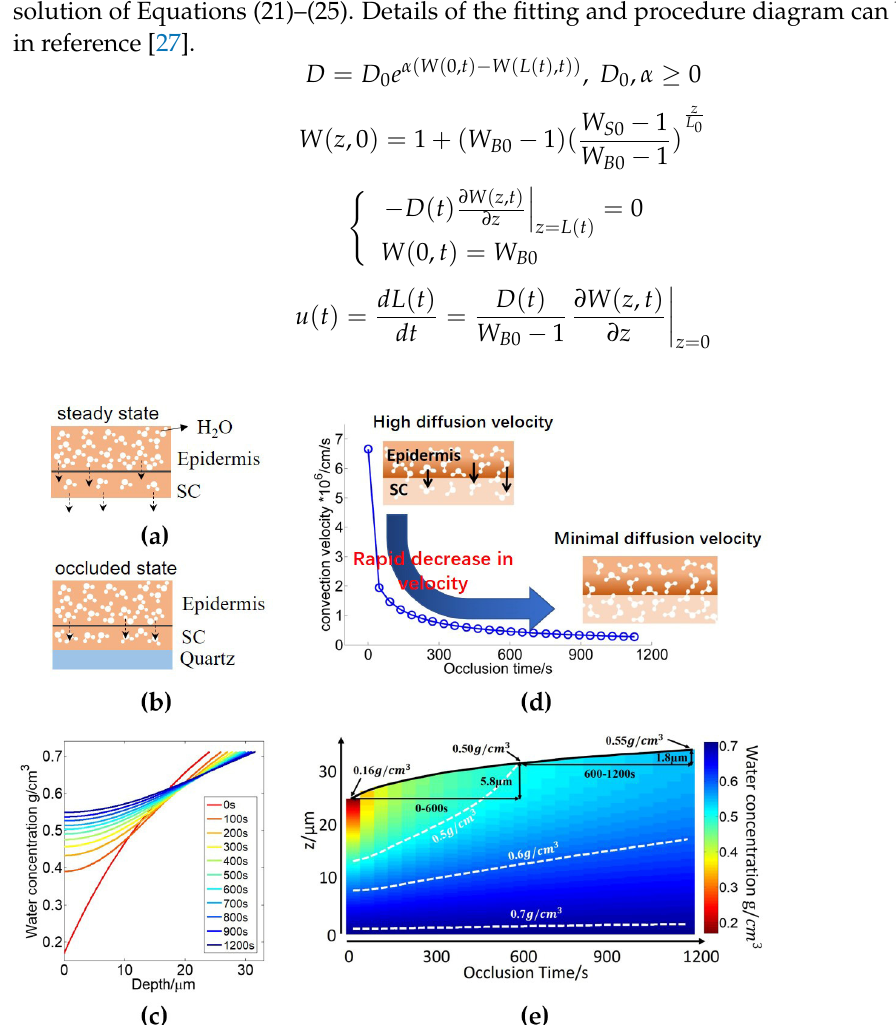
Figure 9. ( a ) Water dynamics of skin in a steady state; ( b ) Water dynamics of skin under occlusion; ( c ) The water concentration profile at different occlusion times; ( d ) The convection velocity as a function of the occlusion time; ( e ) A colormap of the water concentration as a function of depth (z) in skin and occlusion time. The black curve shows the change in the thickness of the SC with occlusion time. The white dashed curves are the contour lines of the water concentration at 0.5, 0.6 and 0.7 g/cm 3 . Reprinted with permission from ref. [27] Copyright 2019 Journal of Biophotonics.